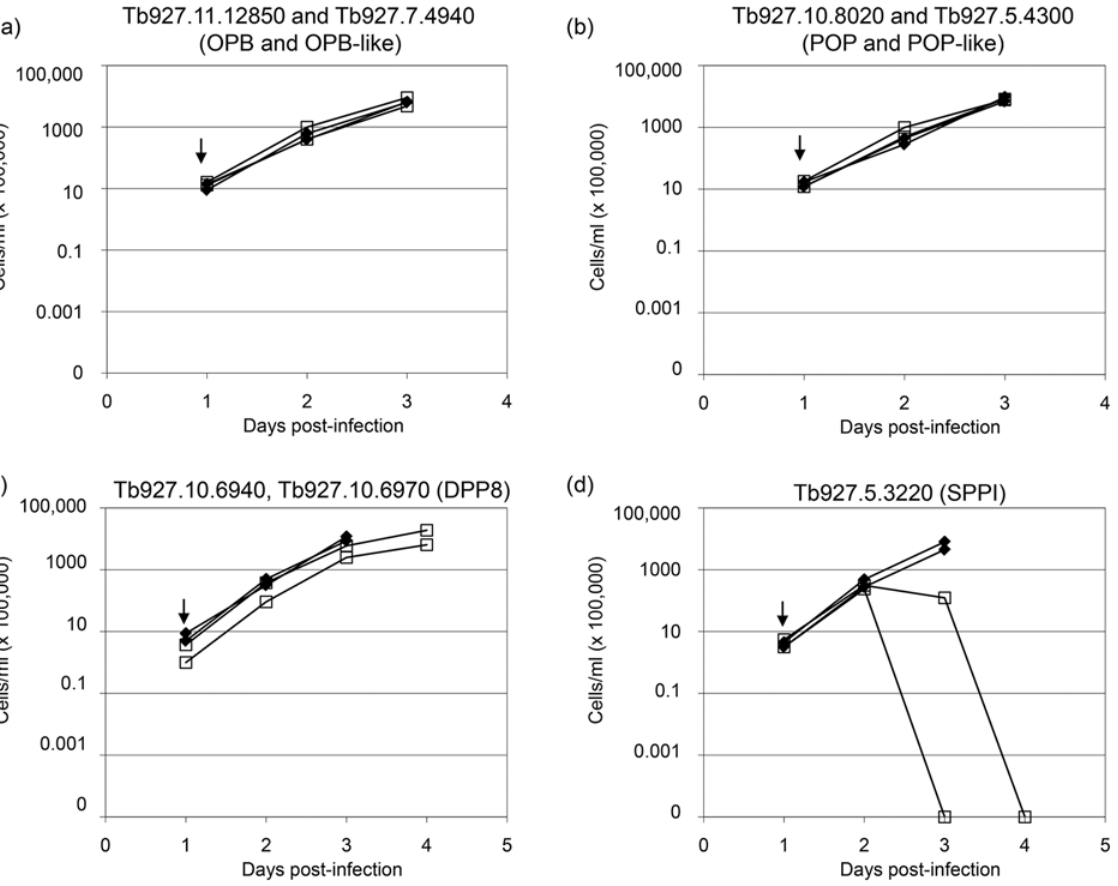
Fig 2. Effect of RNAi on T . brucei cell growth in vivo . ICR mice were inoculated with RNAi cell lines targeting the two OPB-like genes (a), two POP-like genes (b), dipeptidyl peptidase-8 (c), or the type-I signal peptidase (d). Two mice in each experiment were left untreated (filled symbols) and two were given doxycycline (open symbols) to induce RNAi. The arrow indicates doxycycline administration. Parasitaemia in infected mice was counted at the times indicated.